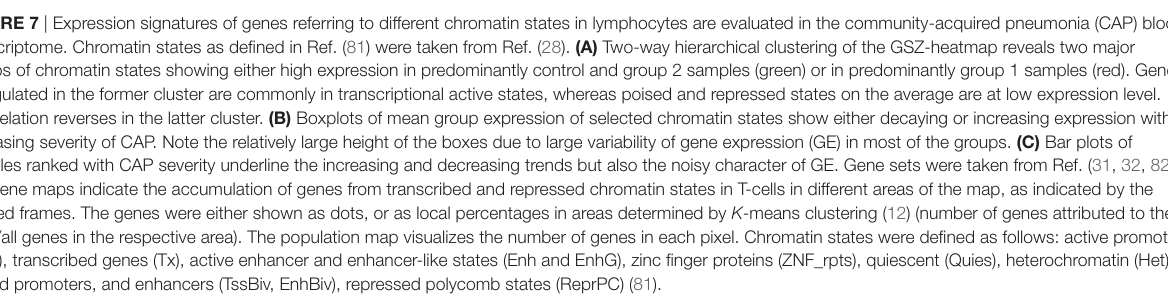
FigUre 7 | Expression signatures of genes referring to different chromatin states in lymphocytes are evaluated in the community-acquired pneumonia (CAP) blood transcriptome. Chromatin states as defined in Ref. (81) were taken from Ref. (28). (a) Two-way hierarchical clustering of the GSZ-heatmap reveals two major groups of chromatin states showing either high expression in predominantly control and group 2 samples (green) or in predominantly group 1 samples (red). Genes upregulated in the former cluster are commonly in transcriptional active states, whereas poised and repressed states on the average are at low expression level. This relation reverses in the latter cluster. (B) Boxplots of mean group expression of selected chromatin states show either decaying or increasing expression with increasing severity of CAP. Note the relatively large height of the boxes due to large variability of gene expression (GE) in most of the groups. (c) Bar plots of samples ranked with CAP severity underline the increasing and decreasing trends but also the noisy character of GE. Gene sets were taken from Ref. (31, 32, 82). (D) Gene maps indicate the accumulation of genes from transcribed and repressed chromatin states in T-cells in different areas of the map, as indicated by the dashed frames. The genes were either shown as dots, or as local percentages in areas determined by K -means clustering (12) (number of genes attributed to the state/all genes in the respective area). The population map visualizes the number of genes in each pixel. Chromatin states were defined as follows: active promoters (TssA), transcribed genes (Tx), active enhancer and enhancer-like states (Enh and EnhG), zinc finger proteins (ZNF_rpts), quiescent (Quies), heterochromatin (Het), poised promoters, and enhancers (TssBiv, EnhBiv), repressed polycomb states (ReprPC)